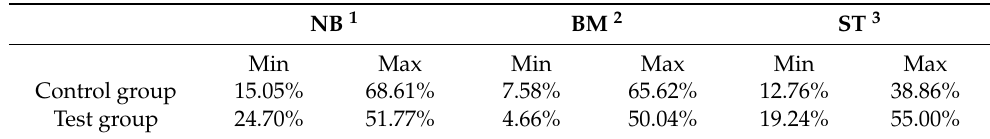
Table 2. Minimum and maximum values of newly formed bone, residual biomaterial, and soft tissue between the control and test groups, expressed in percentages.